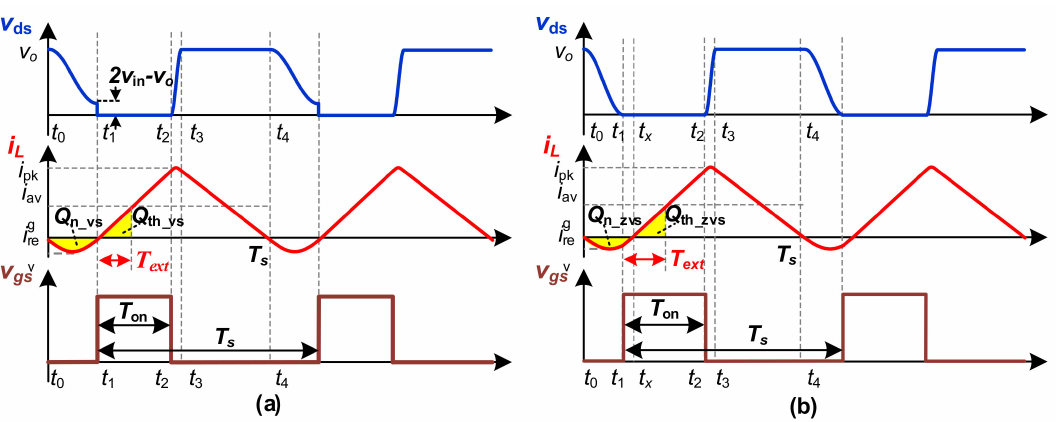
Figure 7. Diagram of the key inductor charge and the extended time of the ACVOT control: ( a ) the vs. condition (2 v in > v o ); the ( b ) ZVS condition (2 v in < v o